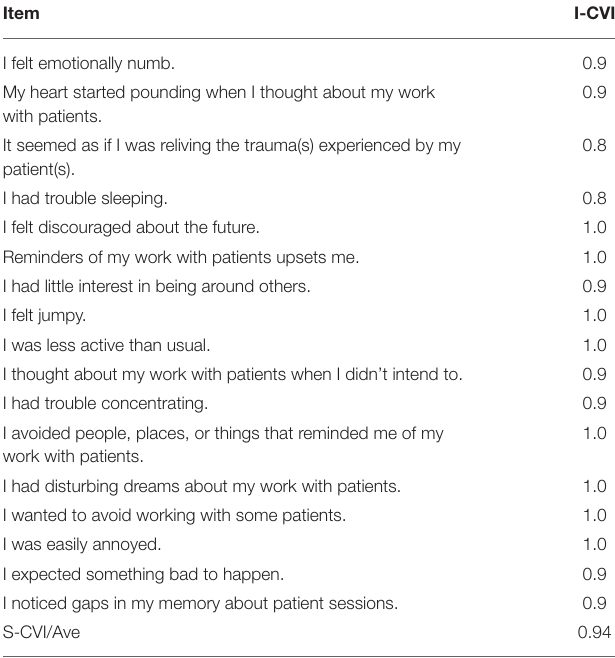
TABLE 3 | Content validity of C-STSS ( n =